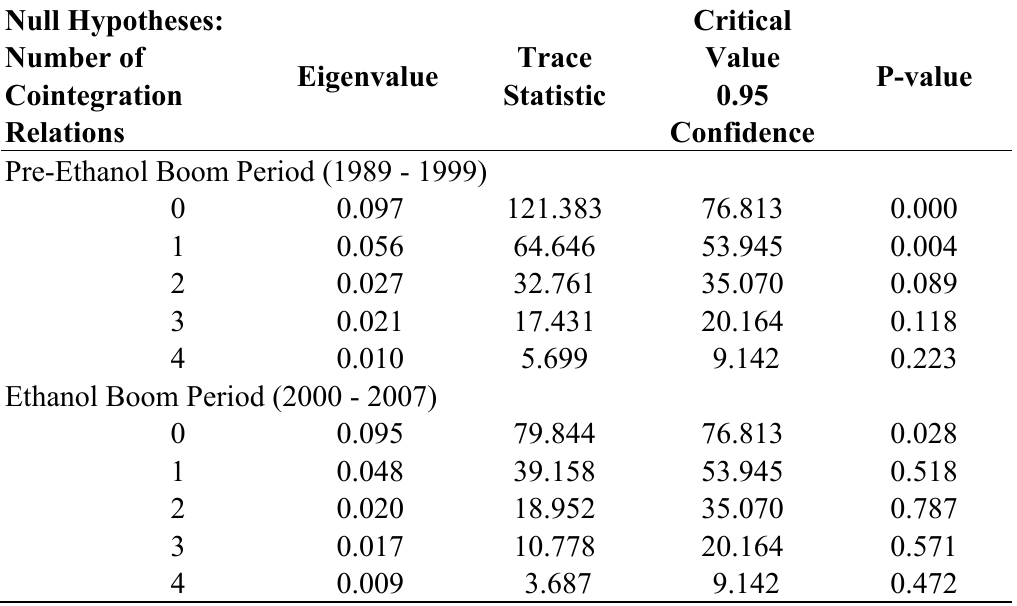
Table 3. Cointegration Trace